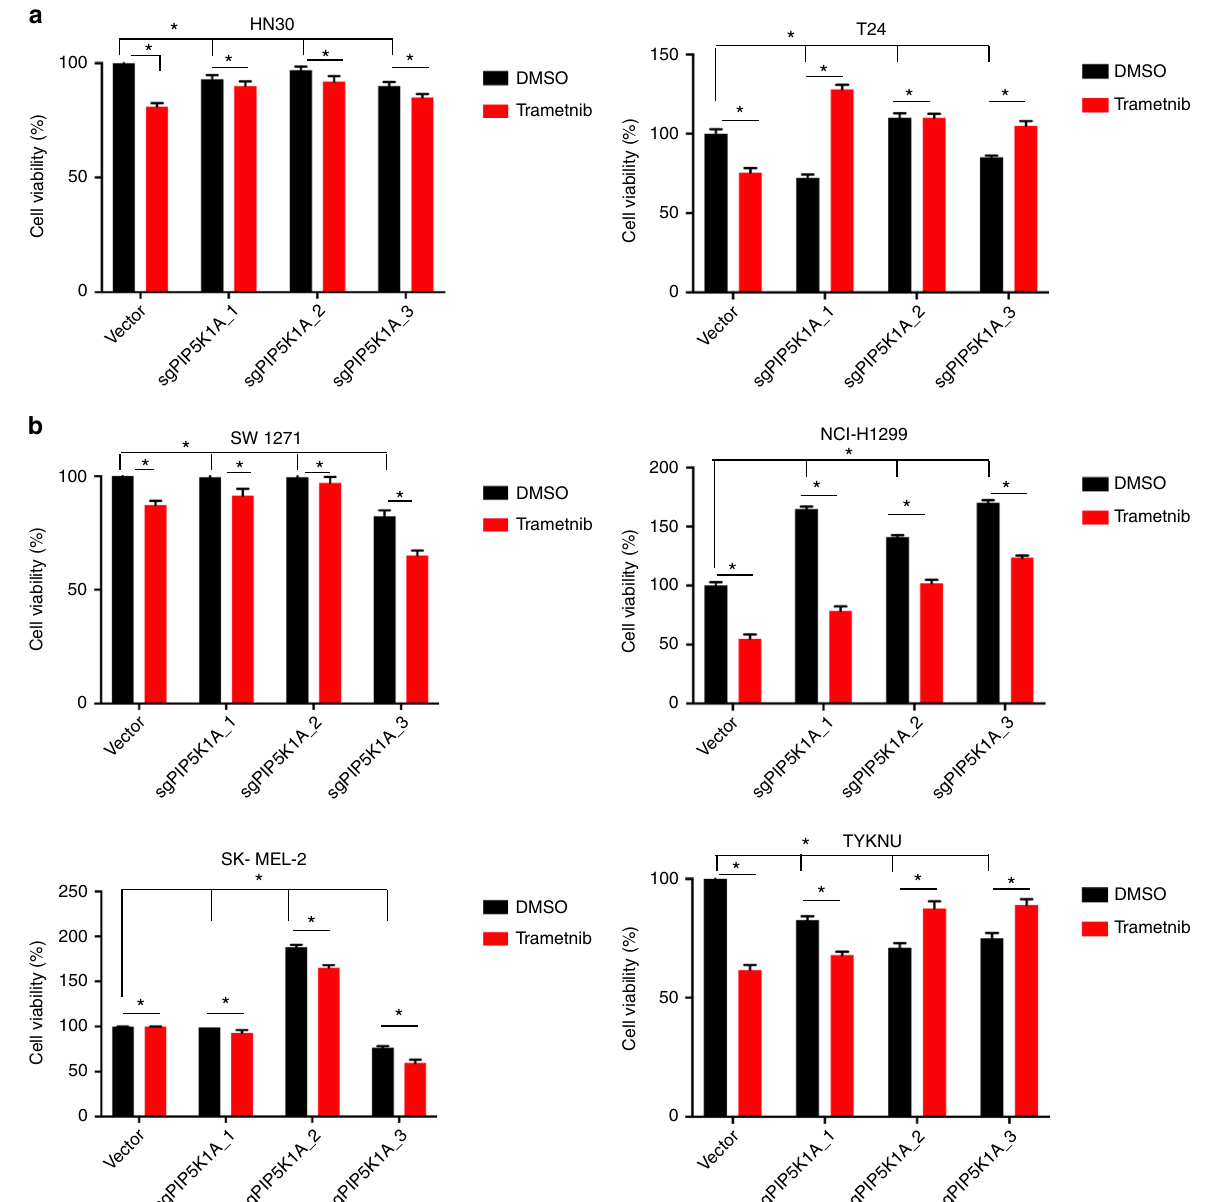
Fig. 7 PIP5K1A loss has minimal impact on HRAS -mutant or NRAS -mutant cancer cells. Percent cell viability (mean ± SD, triplicate samples, two experiments, normalized to vector control cells treated with DMSO) of the indicated a HRAS -mutant and b NRAS -mutant human cancer cell lines stably infected with a lentiviral vector encoding Cas9 and no transgene (vector) or one of up to three independent sgRNA targeting PIP5K1A (sgPIP5K1A-1 to -3) after treatment with vehicle (DMSO) or 25 nM of trametinib for 72 h. * p = 0.05, two-way ANOVA